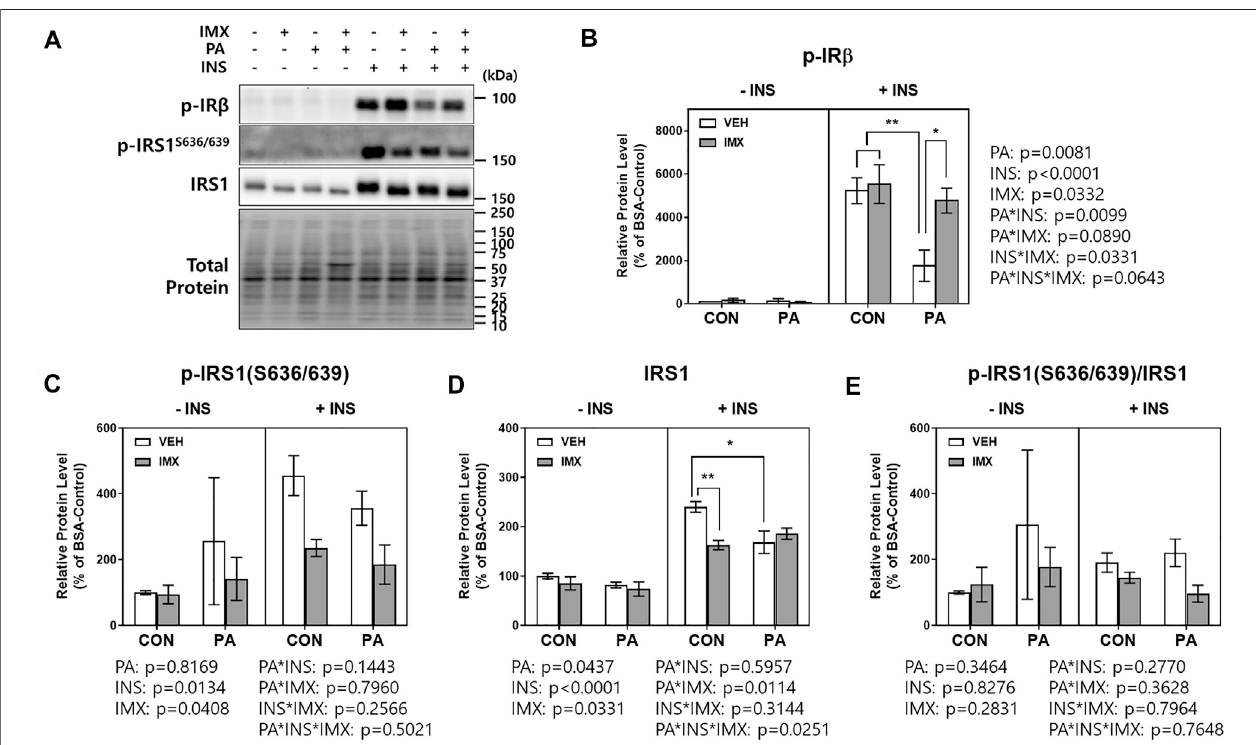
FIGURE5 | Effectofimoxinon insulin-stimulated p-IR β and IRS1 phosphorylationin presence or absence ofpalmitate in C2C12 myotubes. The cells weretreated with imoxin (IMX) at 5 μ M with/without 0.5 mM palmitate (PA) for 24 h. Protein level of each biomarker was measured by western blot. (A) Representative band images and (B – E) quanti fi cation data of each biomarker are shown. Differences between treatments were analyzed by three-way ANOVA (IMX x PA x insulin). Values are presented as mean ± SEM (N = 3). * p < 0.05 and ** p < 0.01 by Tukey ’ s post hoc analysis after three-way ANOVA.